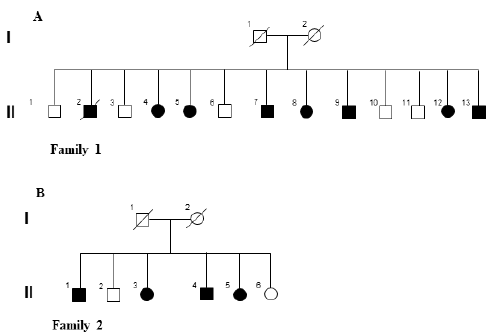
Figure 1. Pedigrees of the two Italian families. ( A , B ) Graphical representation of the two LOPD Italian families. The affected siblings are reported with filled symbols.